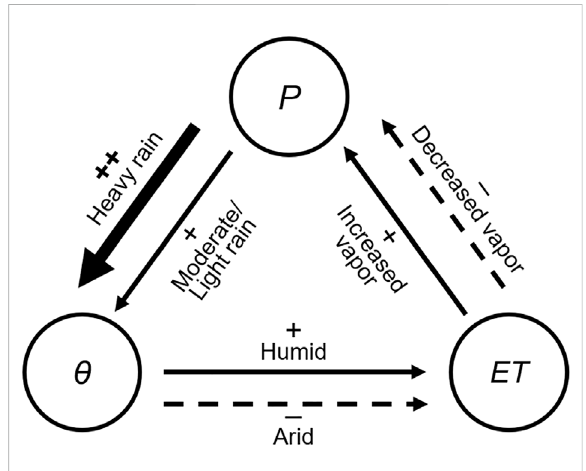
FIGURE 7 Detailed θ - P feedback loop built from the sensitivity